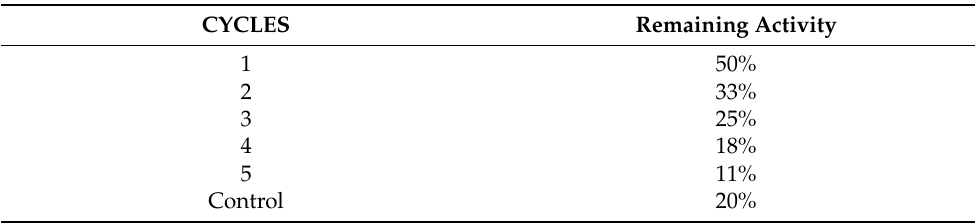
Table 1. Trypsin activity after successive synthesis cycles. The activity was measured after 2 h at 405 nm.